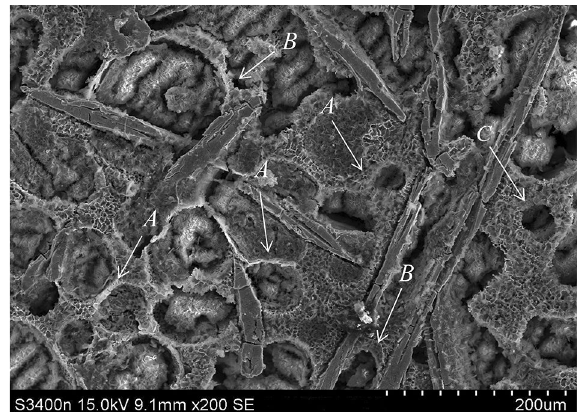
Figure 4. Microstructure of Al–Fe–Cu alloy was quenched after heating at 630 °C for 40 min, deep etched. The α-Al grain was corroded into a cavity with a white rich-Al brim, the re-solidified region presented the fine mesh structure. A, B and C micro-zones have various distributed condition of the liquid